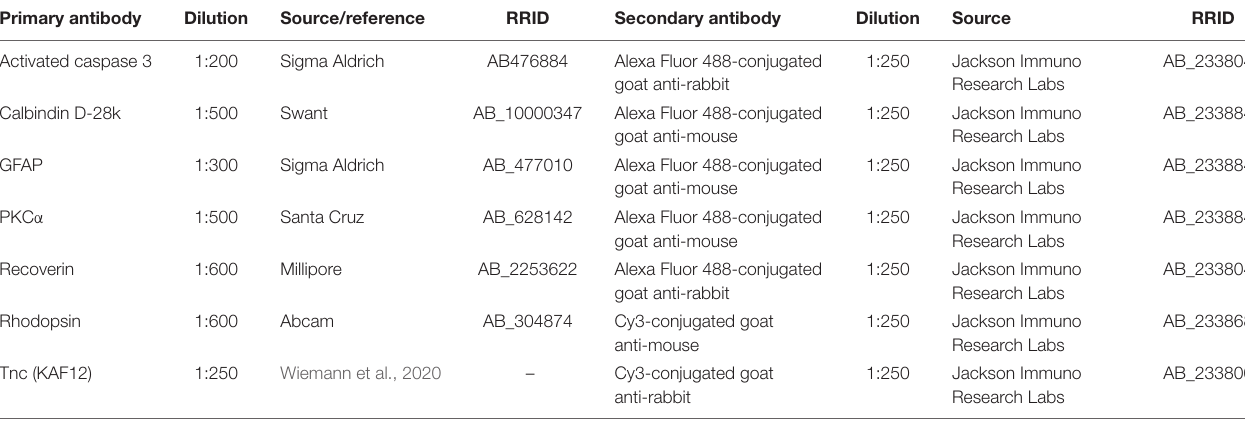
TABLE 1 | Primary and secondary antibodies used for immunohistochemistry.